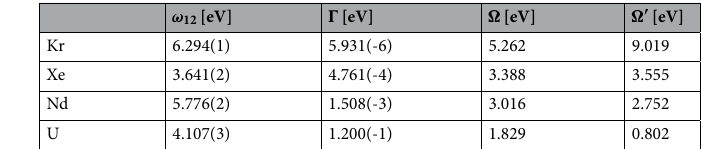
2 p 3 / 2 E 1 transitions in Li-like ions. Transition energies ω 12 , natural line ↔